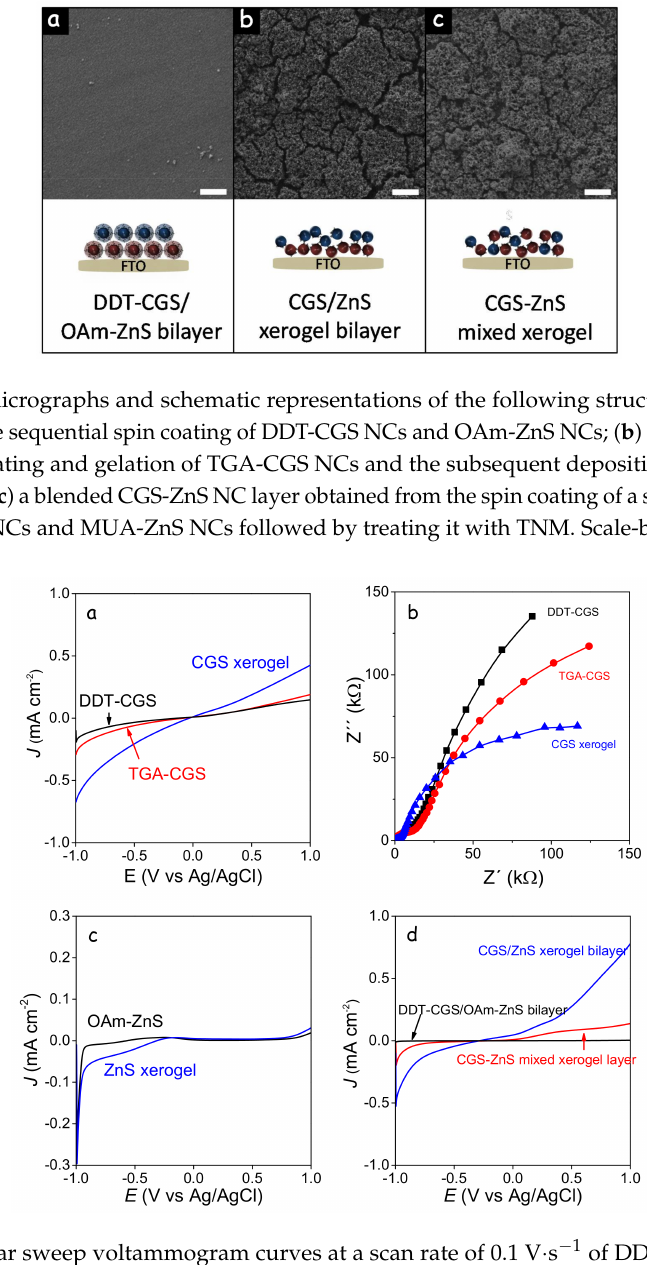
Figure 9. ( a ) linear sweep voltammogram curves at a scan rate of 0.1 V · s − 1 of DDT-CGS, TGA-CGS and gelated TGA-CGS NC-based layers; ( b ) Nyquist plots for DDT-CGS, TGA-CGS and CGS xerogel films; ( c ) linear sweep voltammogram curves at a scan rate of 0.1 V · s − 1 of OAm-ZnS and gelated MUA-ZnS NC-based layers; ( d ) linear sweep voltammogram curves at a scan rate of 0.1 V · s − 1 of DDT-CGS/OAm-ZnS NC-based bilayer, a gelated TGA-CGS/MUA-ZnS NC-based bilayer and a gelated layer produced from a blend of TGA-CGS and